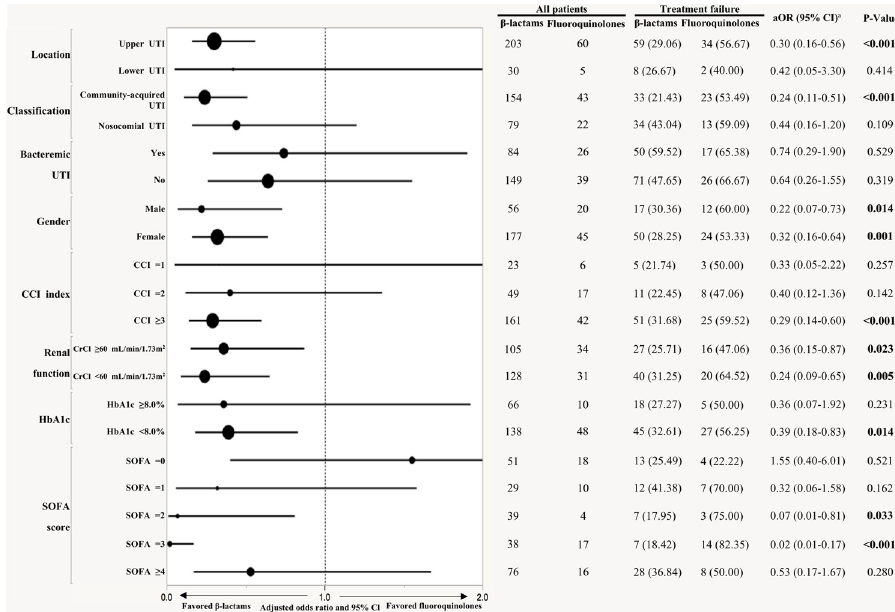
Fig 3. Forest plot of treatment failure by patient characteristics. Data were presented as N (%). The fluoroquinolones group was the reference group. The horizontal lines running through the dots represented the 95% CIs. The size of the dot for each aOR in the plot is proportional to the number of patients. UTI: Urinary tract infection; CCI: Charlson comorbidity index; Clcr: Creatinine clearance; SOFA: sequential organ failure assessment; Adjusted covariates in aOR: age, AMI, temperature. P-value was calculated by multivariable logistic